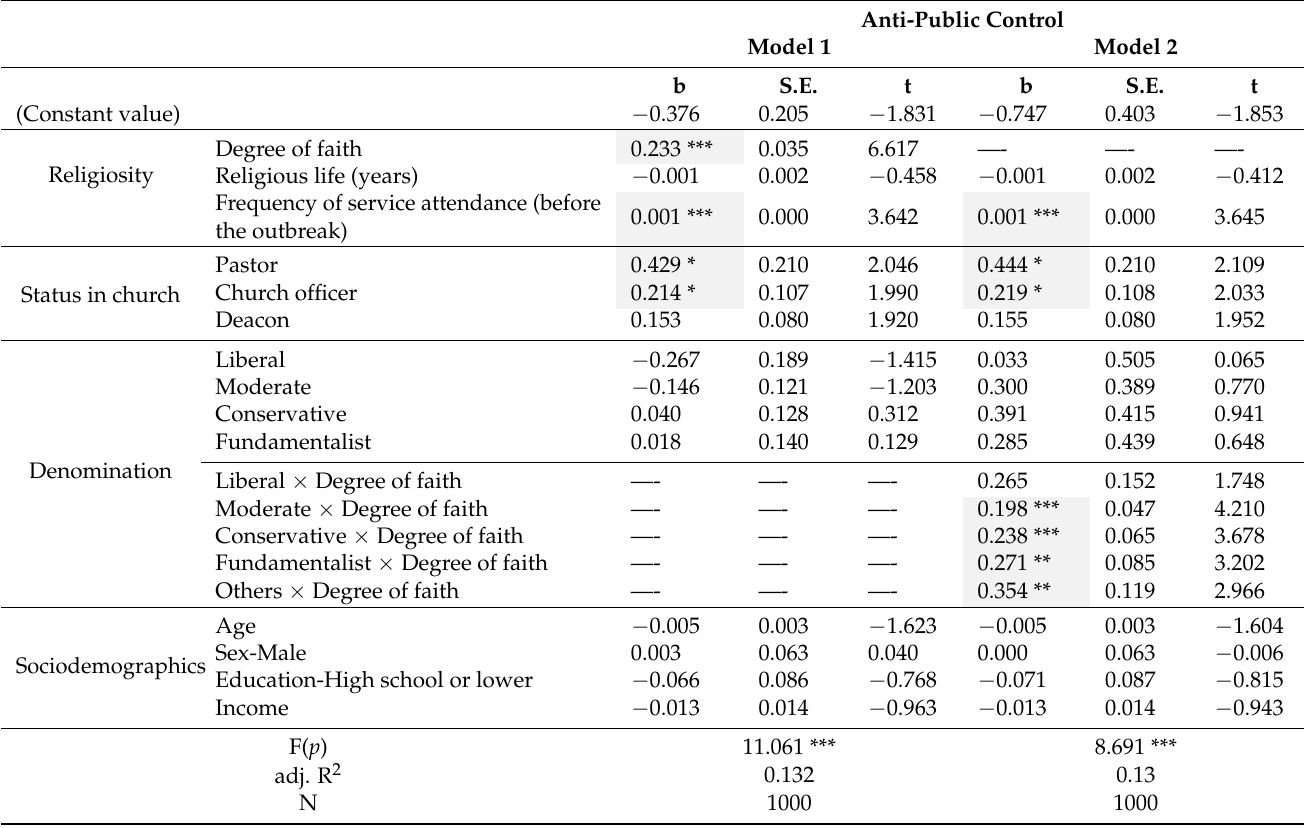
Table 13. OLS regression models predicting Protestants’ anti-public control attitudes during the COVID-19